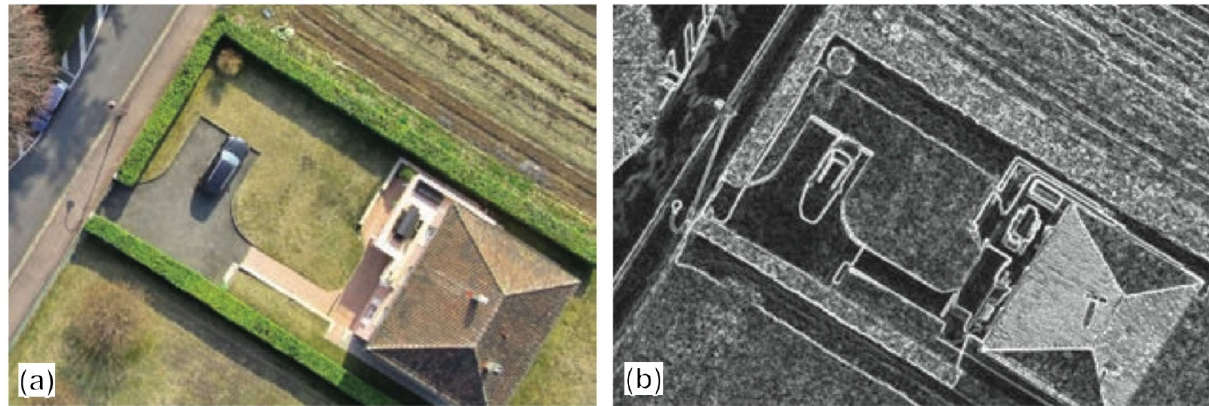
Figure 9. ( a ) Original high spatial resolution color image, ( b ) filtering image using Robert filtering derived from [64].